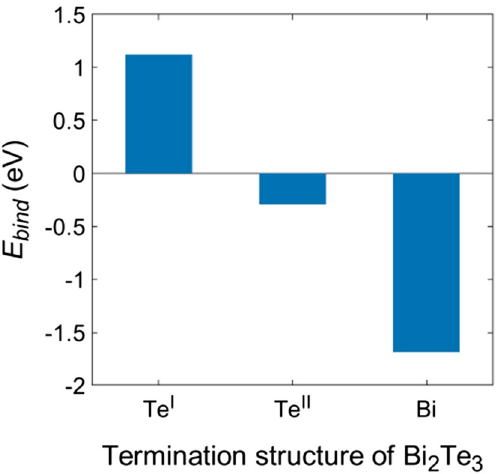
Figure 2. Binding energies of various Bi 2 Te 3 /MASnI 3 interfaces with different Bi 2 Te 3 termination